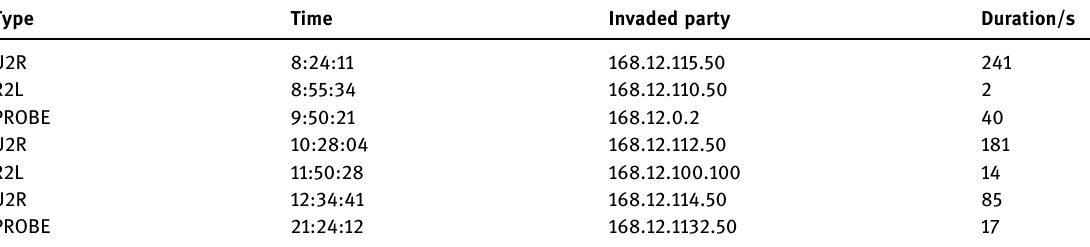
Table 1: Security event